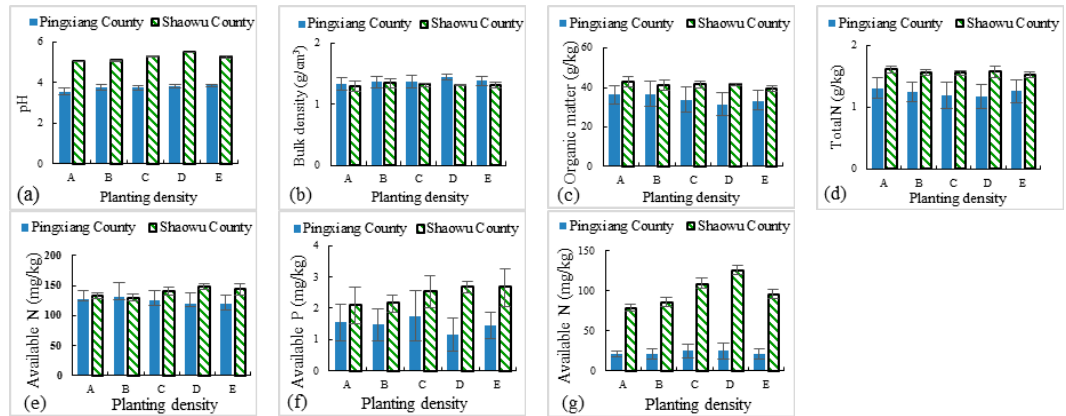
Figure 12. The comparison of ( a ) soil pH, ( b ) bulk density, ( c ) organic matter, ( d ) total N, ( e ) available N, ( f ) available P, ( g ) available K in the 0–20 cm soil layer between two sites (Pingxiang county and Shaowu county) under five different stand densities.